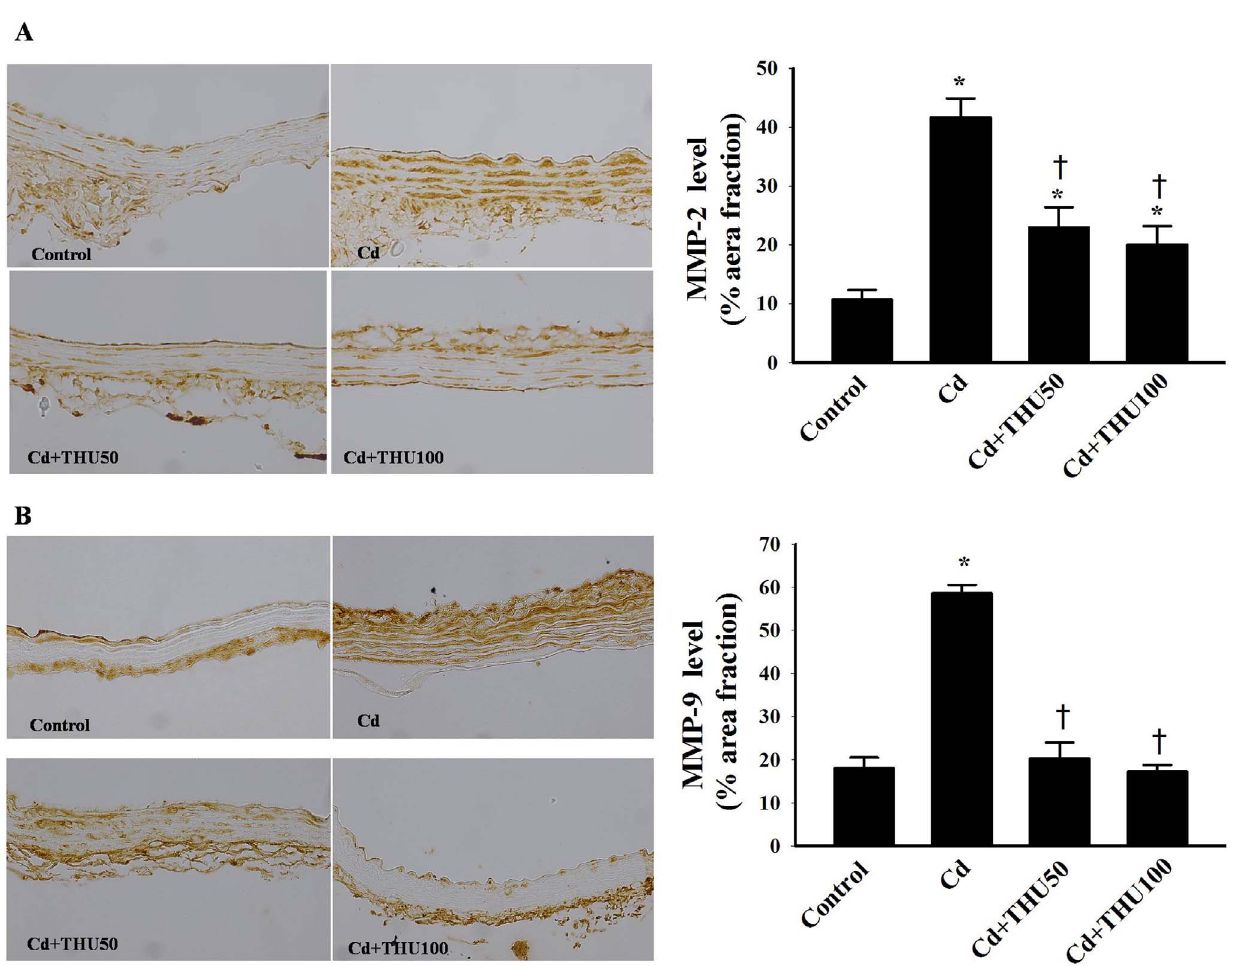
Fig. 5. Effect of THU on MMP-2 (A) and MMP-9 (B) localization assessed by immunohistochemistry in the aortas of all experimental groups. Panels A and B are representative photographs of MMP-2 and MMP-9 expressions respectively (400 6 ). Results are expressed as mean ¡ SEM., n 5